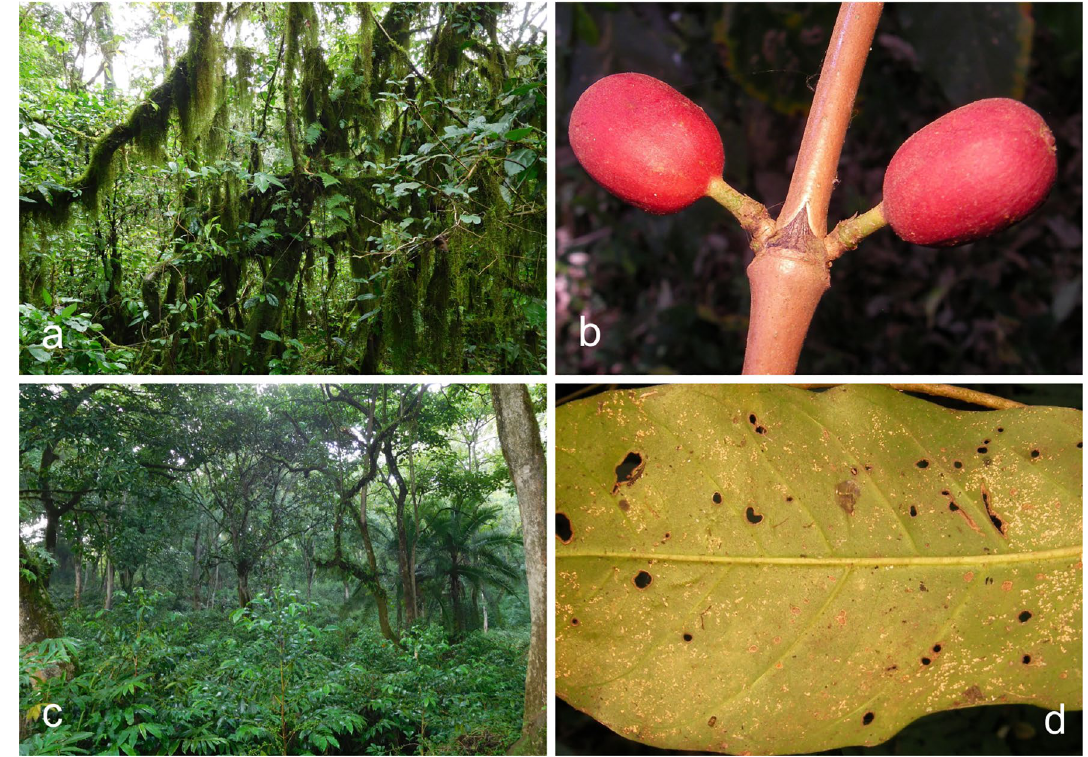
Figure 14. Survey in Ethiopia. ( a ) Komba Forest Reserve, Kaffa Zone, at ca. 2000 m altitude; showing wild Coffea arabica in the cloud forest understorey. ( b ) Wild Coffea arabica in Komba Forest Reserve with few, large berries at each node in contrast to the multiple, smaller berries of commercial varieties. ( c ) Typical semi-wild coffee farm of the Kaffa Zone, at ca. 1500 m altitude, established under thinned forest. ( d ) Leaf from the above wild coffee plant colonized by two rust species: the dominant white scattered pustules of Hemileia cf. coffeicola ; and a typical orange dense pustule of H . vastatrix , an uncommon rust in cloud